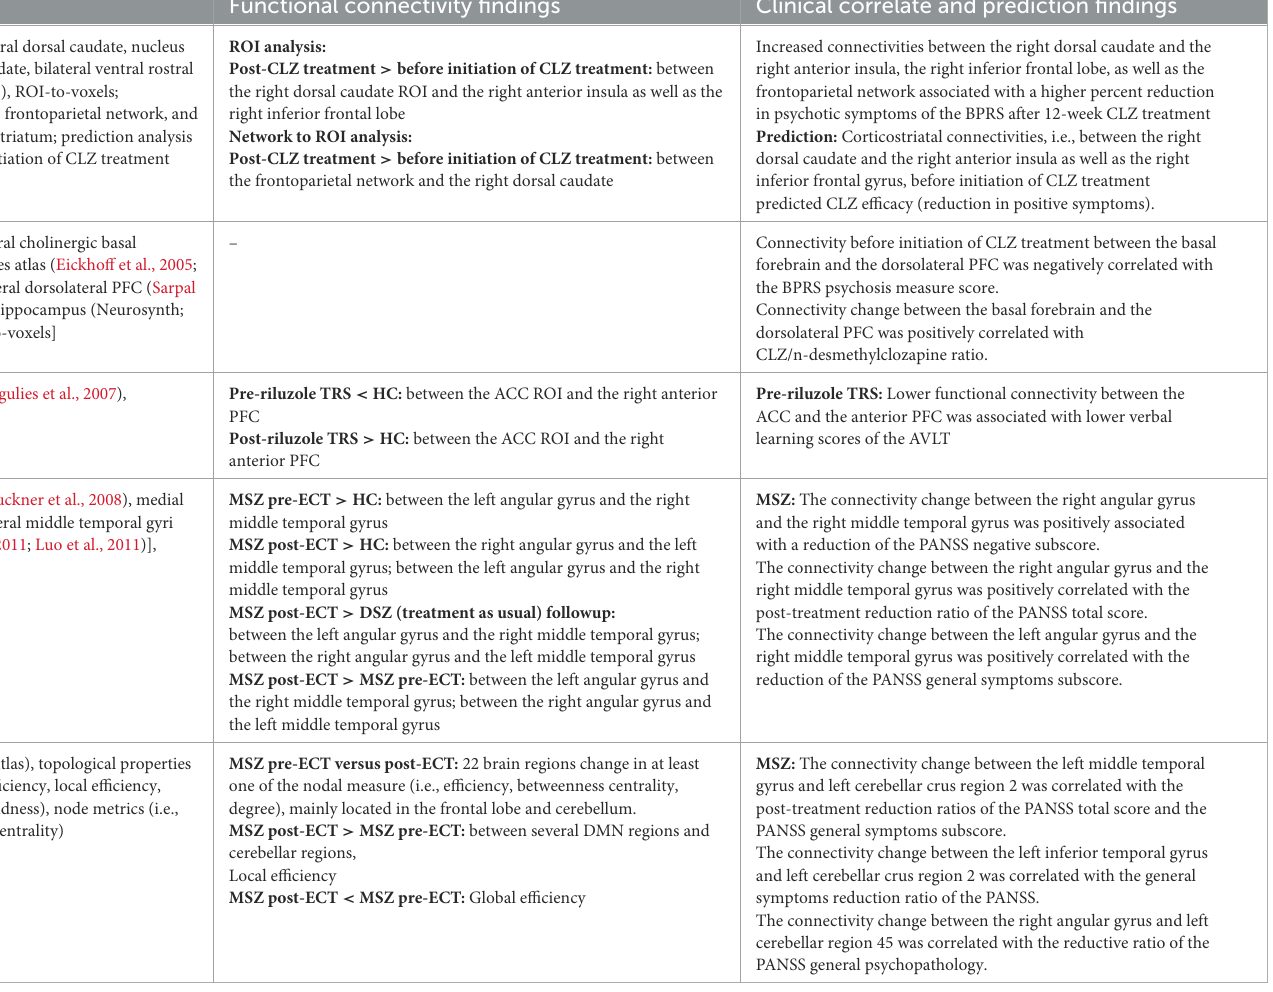
the right dorsal caudate ROI and the right anterior insula as well as the right inferior frontal lobe Network to ROI analysis: Post-CLZ treatment > before initiationof CLZ treatment: between the frontoparietal network and